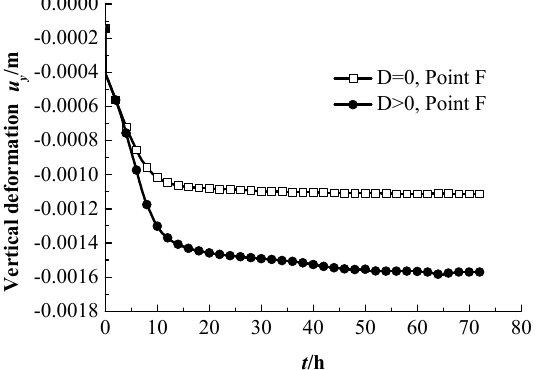
Figure 18. Curves of the vertical deformation of Point F with and without considering damage of hydrate-bearing sediments.